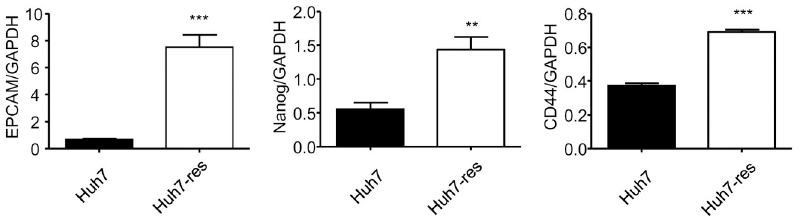
Fig 3. Related mRNA expression of stemness markers were upregulated in sorafenib-resistant Huh7 cells. PCR quantification of EpCAM, Nanog and CD44 mRNA expressed in sorafenib-resistant Huh7 cells compared with normal Huh7 cells, expressed for 48h cultured in DMEM (10%FBS). (n = 4) ( � indicates P value < 0.05 �� indicates P value < 0.01 ��� indicates P value < 0.001).